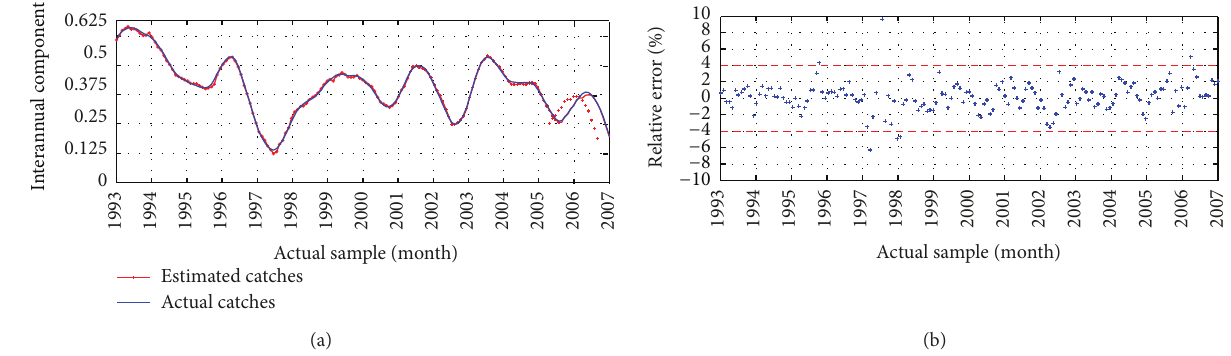
Figure 7: 10 -month-ahead WAR forecasting for interannual component ( 𝑥